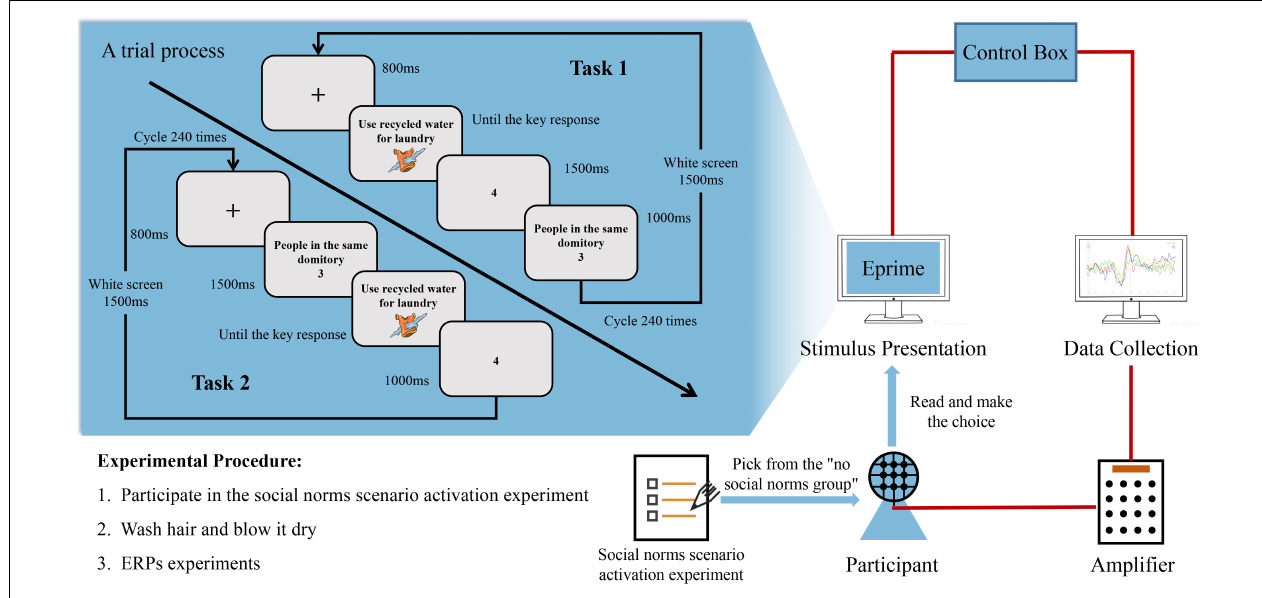
FIGURE 1 | Experiment procedure (The text-type stimulus materials were presented in Chinese in the formal experiment).